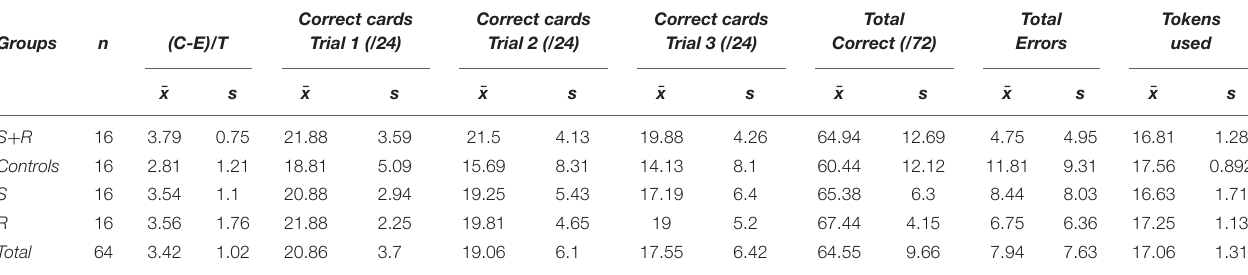
TABLE 3 | Group means for problem-solving